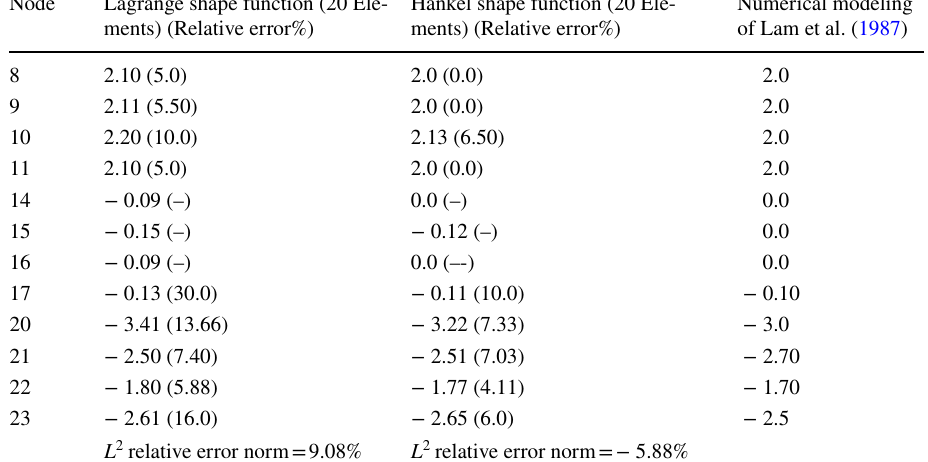
Hankel shape function (20 Ele- ments) (Relative error%)